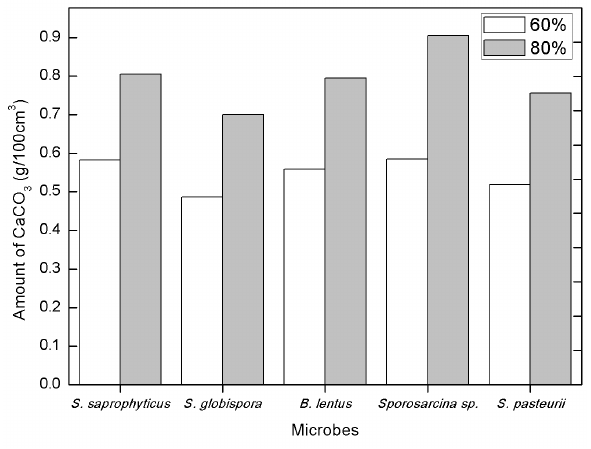
Figure 6. Amount of calcium carbonate.